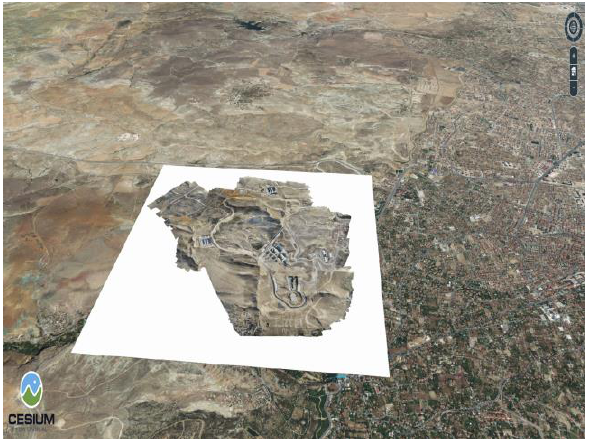
Figure 11. Orthophoto integration.